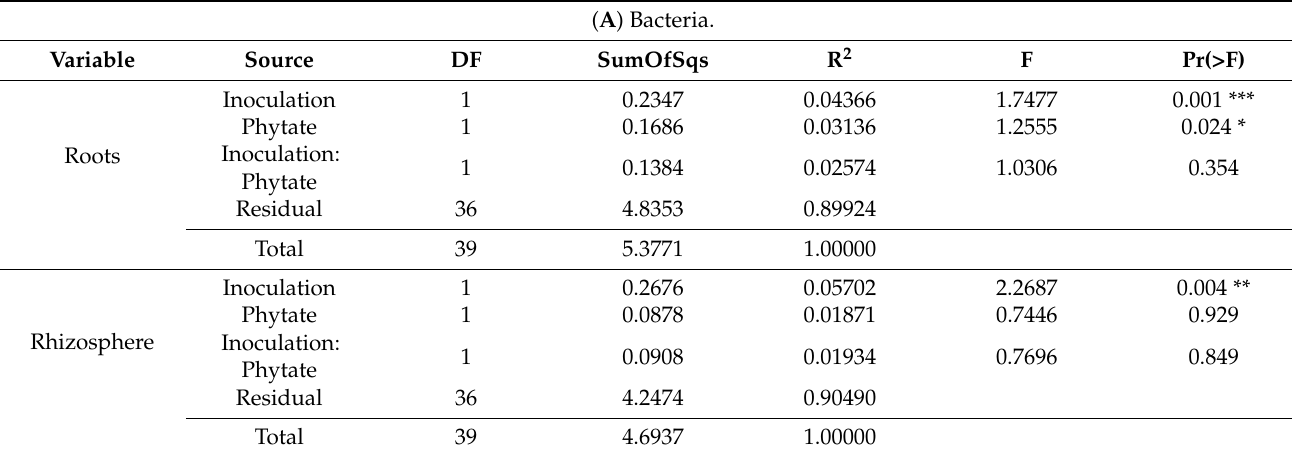
Table 2. Effect of microbial inoculation and phytate on the structure of the bacterial and fungal communities in root and rhizosphere according to PERMANOVA. Rhizosphere refers to rhizosphere soil which is the portion of soil adjacent and influenced by the roots, and inoculation refers to microbial suspension. ( A )